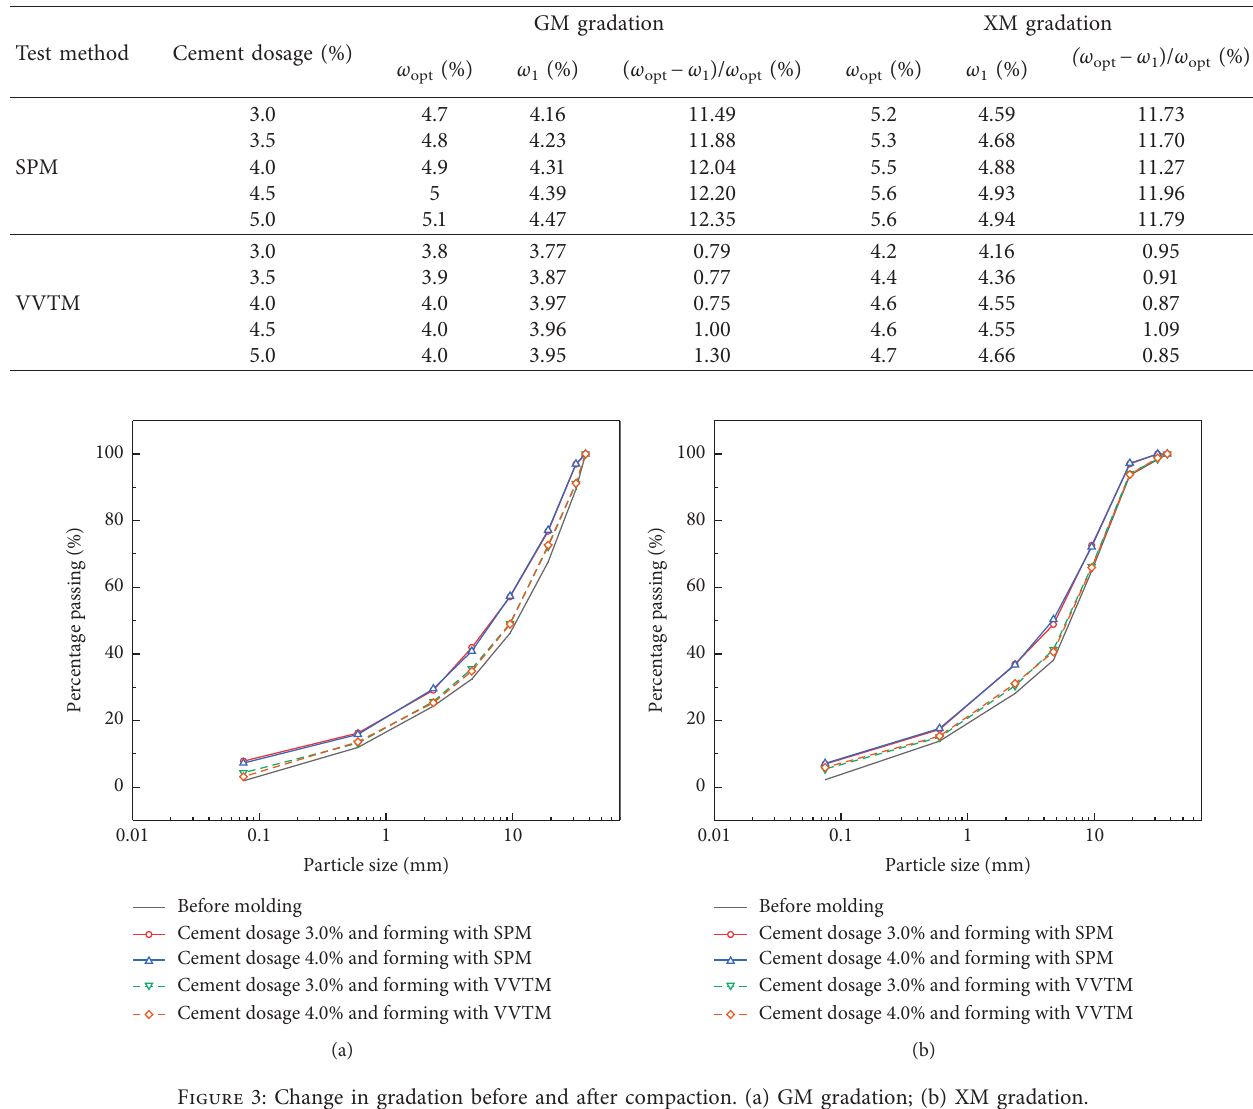
Table 4: Changes in the moisture contents before and after compaction using two methods.